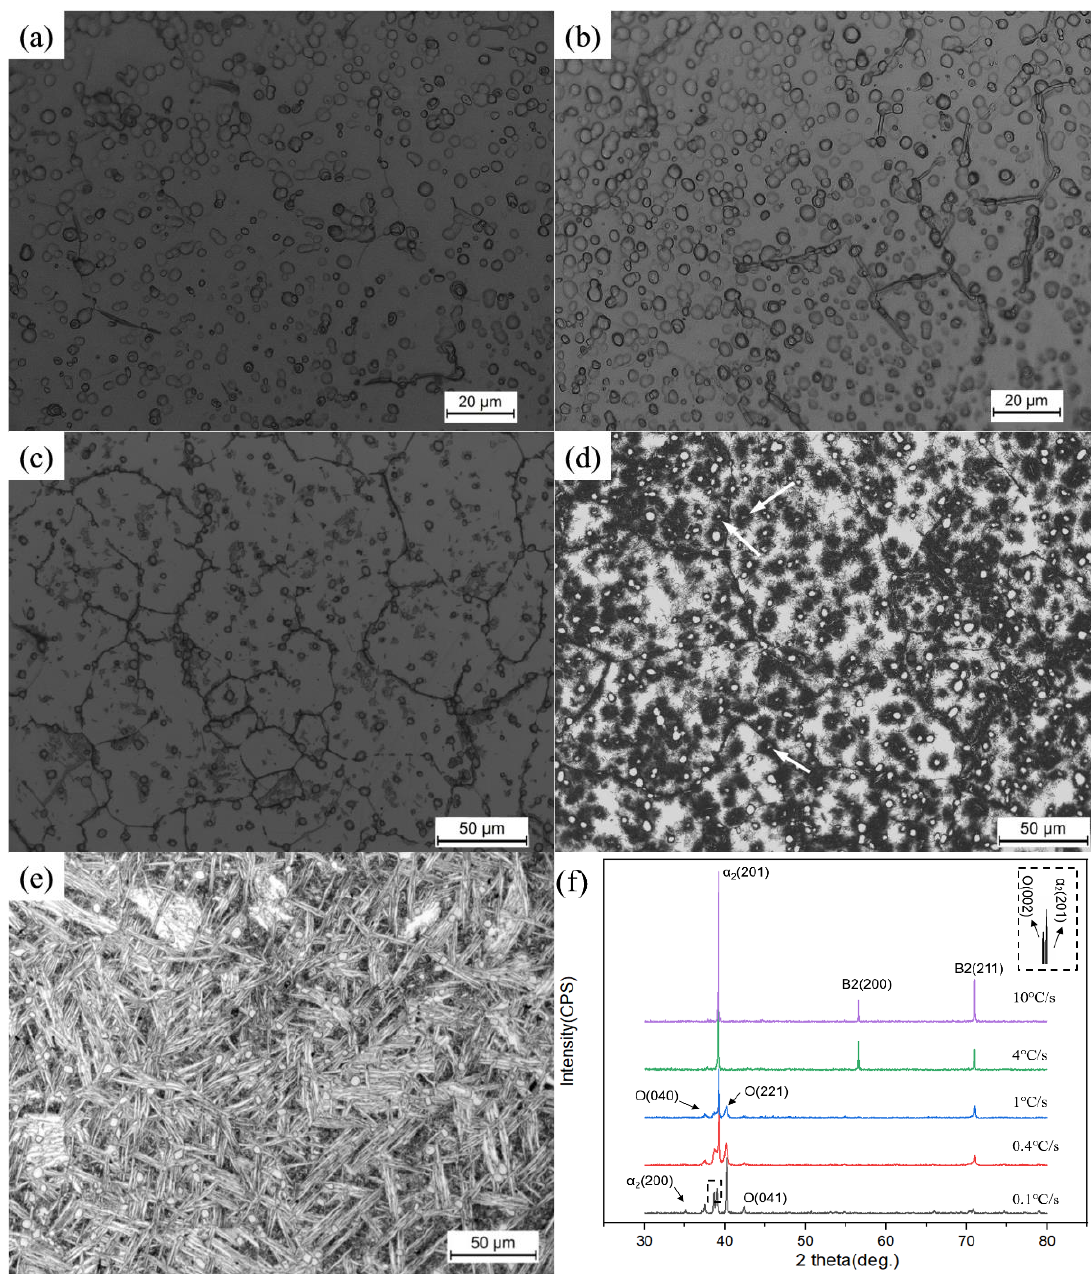
Figure 4. Light microscope images and phase identification of Ti-22Al-25Nb alloy cooled at different rates from 1020 °C: ( a ) 10 °C/s, ( b ) 4 °C/s, ( c ) 1 °C/s, ( d ) 0.4 °C/s, ( e ) 0.1 °C/s, ( f ) XRD pattern.